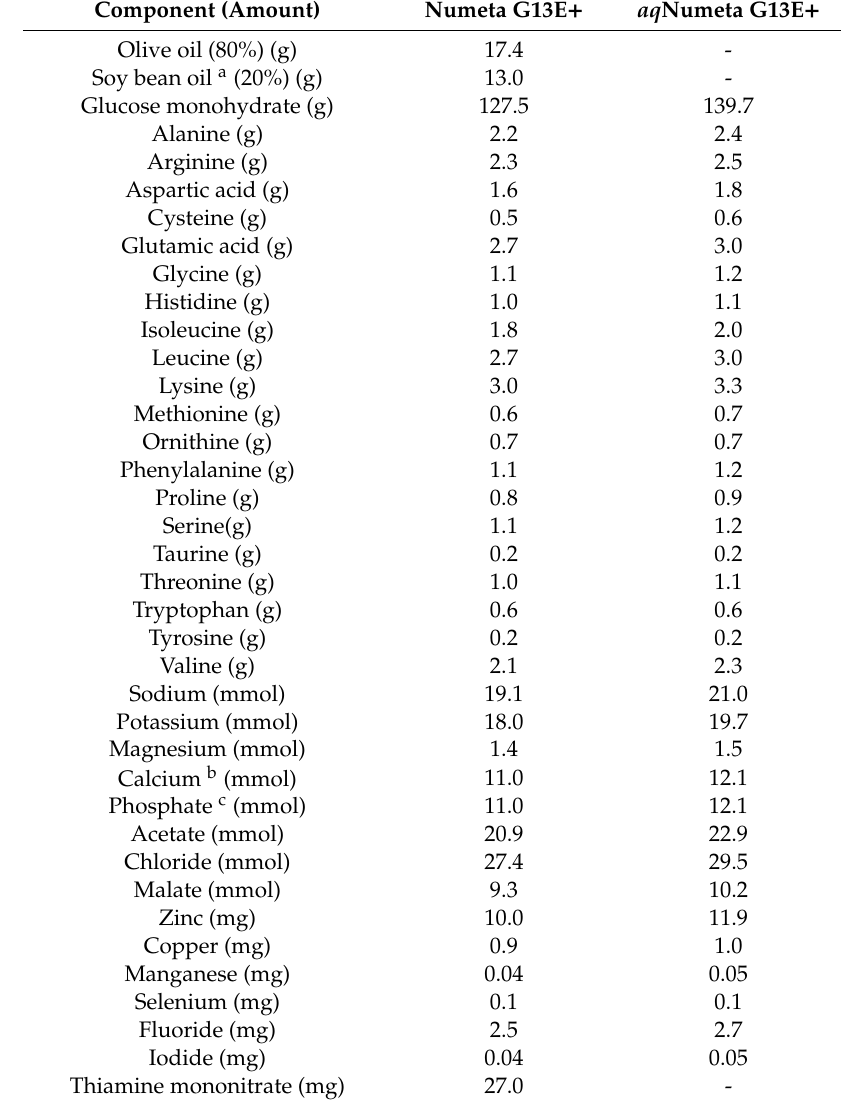
Table 4. Composition of Numeta G13E after mixing and with all additives per L [23]. aq NumetaG13E + refers to the aqueous phase used in tests for assessment of potential